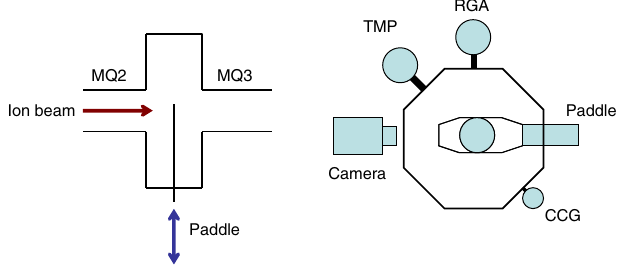
FIG. 1. (Color) Schematic of the optical and fast RGA measure- ment in the magnetic transport section of HCX. The ion beam enters from the left (red arrow) and passes through 4 quadrupole magnets. The paddle in the diagnostic tank between the second and third magnetic quadrupoles (MQ2 and MQ3) is inserted into the path of the beam. A cross section view of the octagonal- shaped diagnostic tank shows the relative location of the paddle and